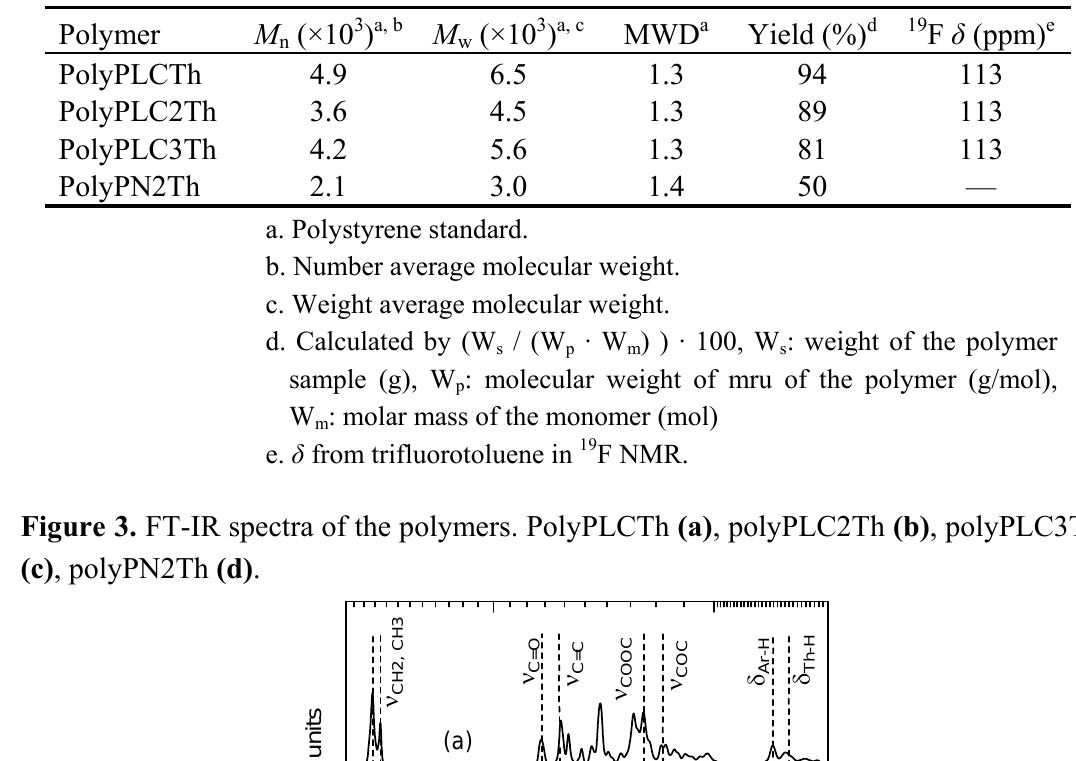
Table 1. Polymerization results.